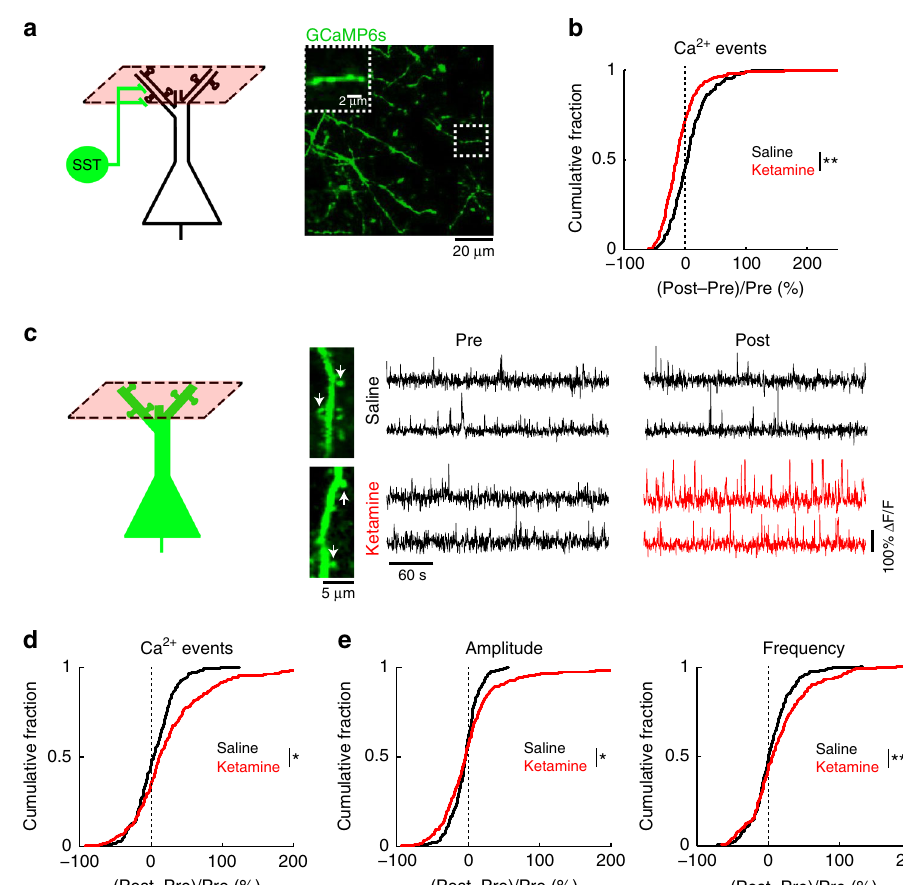
Fig. 2 Ketamine induces opposing effects on dendrite-targeting SST axons and apical dendrites of pyramidal neurons. a Schematic of imaging location, and an in vivo two-photon image of GCaMP6s-expressing SST axons in super fi cial layers of Cg1/M2 of SST-IRES-Cre animals. Inset, magni fi ed view of a SST axonal segment. b The normalized difference in the rate of spontaneous calcium events for SST axons in super fi cial layers. Normalized difference was calculated as post-injection minus pre-injection values normalized by the pre-injection value (ketamine (10 mg/kg): − 9 ± 3%, saline: 12 ± 7%, mean ± s.e. m.; P = 0.002, two-sample t-test). For ketamine, n = 269 boutons from 5 animals. For saline, n = 214 boutons from 5 animals. c Left, schematic of imaging location. Right, each row shows time-lapse fl uorescence transients from the same dendritic spine in the pre-injection (left) and post-injection (right) periods. Two example spines were plotted for saline injection (black) and two other examples were plotted for ketamine (10 mg/kg) injection (pre- injection: black; post-injection: red). Locations of the spines in the in vivo two-photon images are indicated by white arrows. d Same as ( b ) but for dendritic spines in super fi cial layers of Cg1/M2 (ketamine (10 mg/kg): 43.42 ± 0.01%, saline: 4.34 ± 0.01%, mean ± s.e.m.; P = 0.02, two-sample t -test). For ketamine, n = 280 dendritic spines from 5 animals. For saline, n = 231 dendritic spines from 5 animals. e The normalized difference in amplitude (ketamine (10 mg/kg): 5 ± 4%, saline: − 4 ± 1%, mean ± s.e.m.; P = 0.03, two-sample t -test), and frequency of binned calcium events (ketamine (10 mg/kg): 16 ± 4%; saline: 4 ± 2%; P = 0.008, two-sample t -test). * P < 0.05; ** P < 0.01; *** P < 0.001; n.s., not signi fi pre-pulse intensity, F(2,12) = 27.5, P = 4 × 10 − 6 , and drug, F (1,24) = 2.0, P = 2 × 10 − 4 , two-way within-subjects ANOVA); however, it had no effect in mice with bilateral GluN2B-SST KD (main effect of pre-pulse intensity, F(2,24) = 6.3, P = 1.7 × 10 − 4 , but non-signi fi cant drug effect, F(1,12) = 4.0, P = 0.93; Fig. 6c). Bilateral GluN2B-SST KD in Cg1/M2 did not relieve all ketamine-induced abnormalities, as hyperlocomotion persisted (10 mg/kg; Fig. 6d). These results suggest that the effects of ketamine on some, but not all, behaviors rely on perturbing dendritic inhibition.